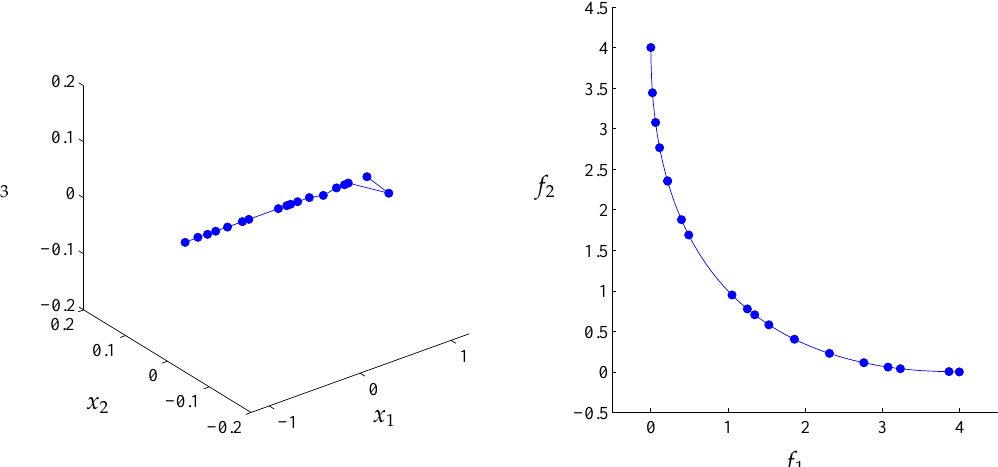
Figure 26. The same as in Figure 24 but for the 500th